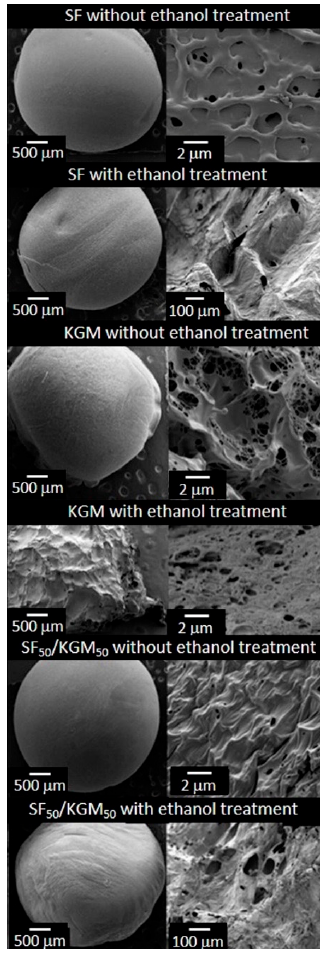
Figure 3. SEM images of the beads surface.